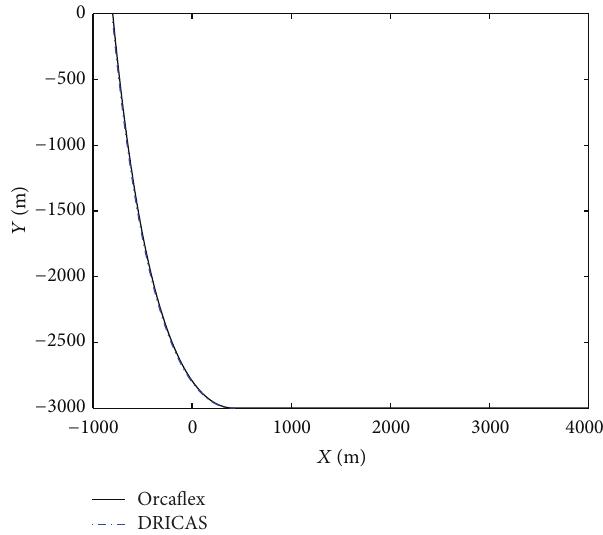
Figure 8: Configuration result comparison between DRICAS and Orcaflex.